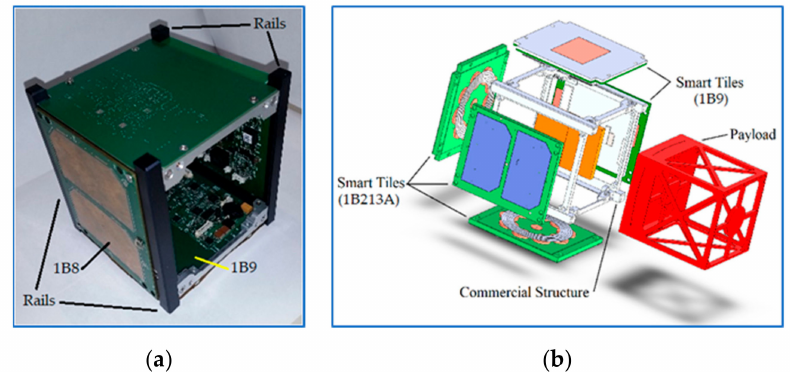
Figure 1. AraMiS CubeSat: ( a ) Prototype and ( b ) General architecture. Integrated bus functions include: power management (in the previous power management tile 1B8 and current work), Tracking, Telemetry and Command (TT & C, telecommunication tile 1B9), and attitude control by reaction wheels (reaction wheel tile 1B213A). Some functions like power generation are distributed over several